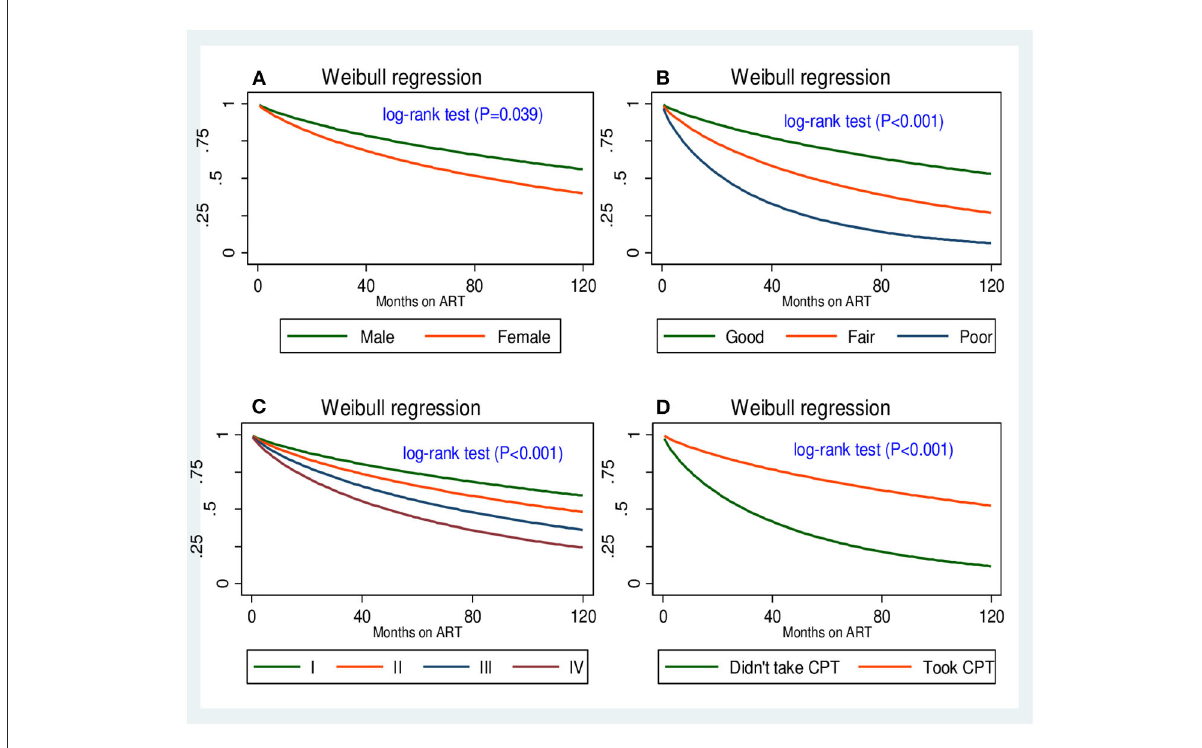
FIGURE4 Four survival functions corresponding to (A) gender, (B) adherence to ART, (C) WHO HIV clinical stage, and (D)